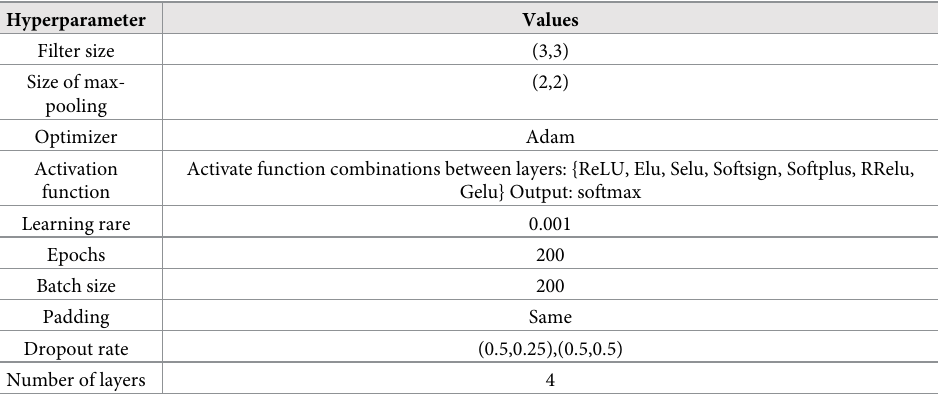
Table 4. Experimental parameter